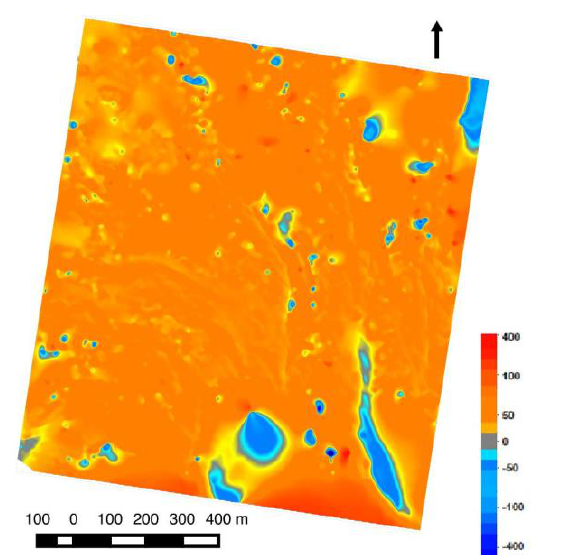
Figure 6 Height difference map for H2162_000 (DLR-VICAR + Kim & Muller with MOLA-DTM. Positive values means higher MOLA-DTM profiles)